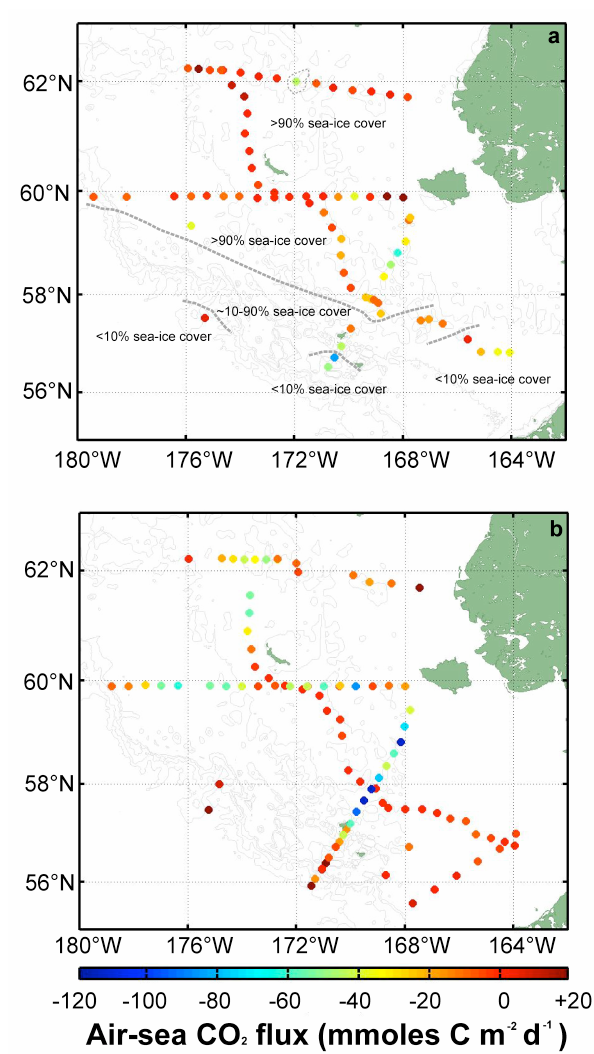
Fig. 7. Air-sea CO 2 flux values calculated at each CTD/hydrocast station in spring and summetime during the 2008 BEST program. (a) Estimated air-sea CO 2 flux (mmoles CO 2 m − 2 d − 1 ) during the 2008 spring BEST cruise; (b) Estimated air-sea CO 2 flux (mmoles CO 2 m − 2 d − 1 ) during the 2008 summer BEST cruise. Approxi- mate sea-ice cover in shown in panel (a) . The influence of sea-ice as a barrier to gas exchange is discussed in Sect.